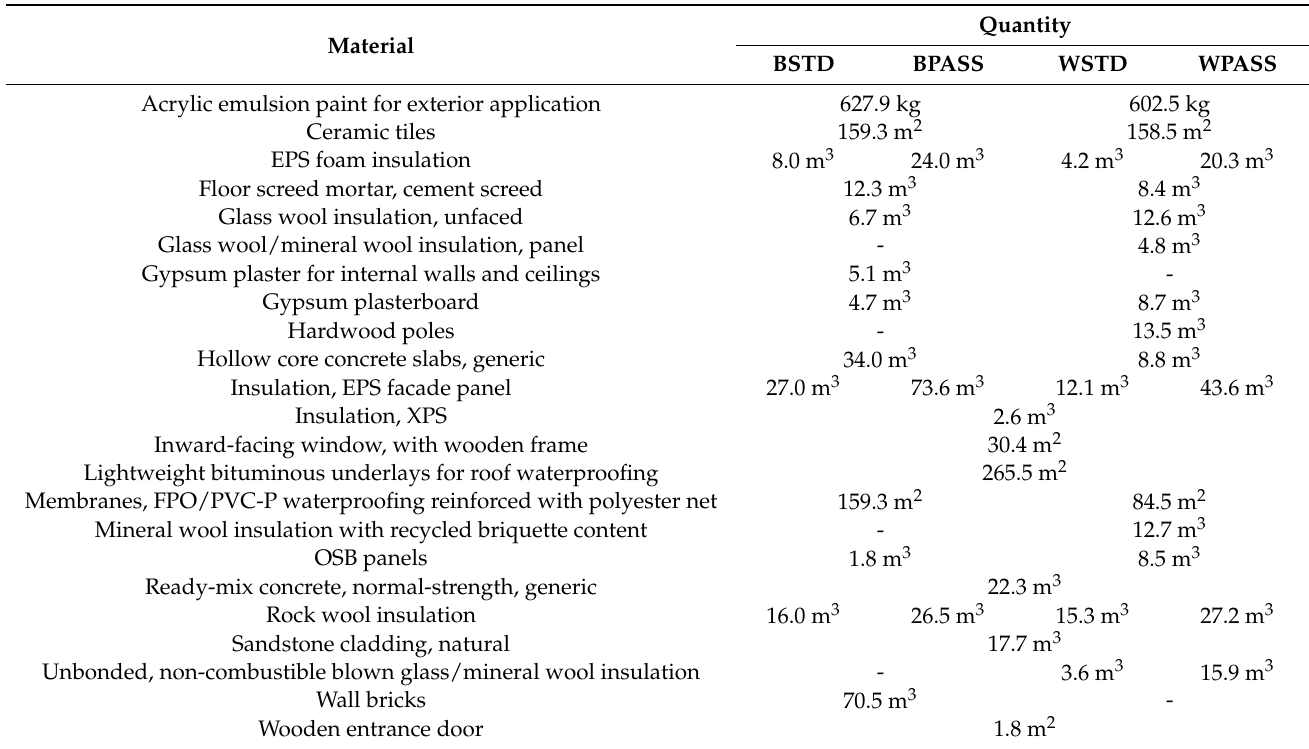
Table A1. Material